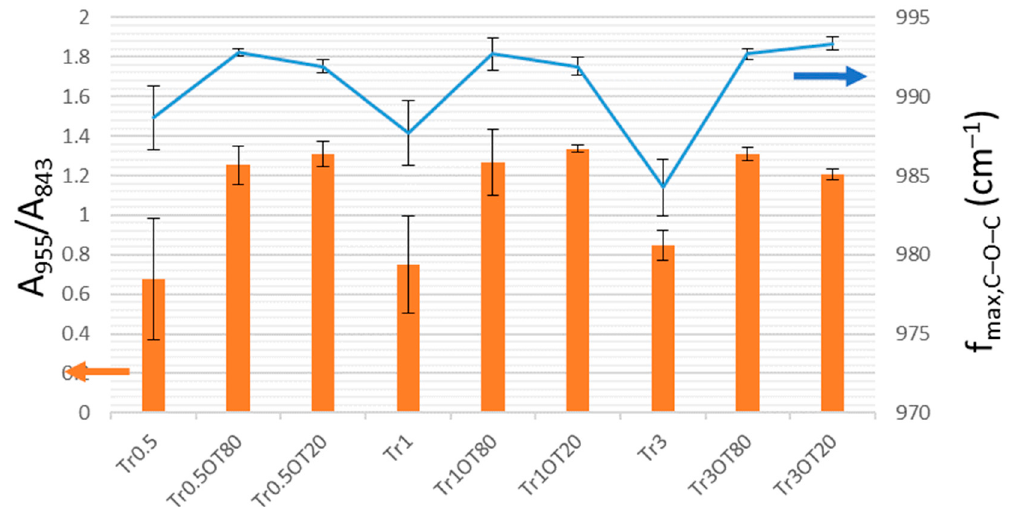
Figure 9. Quantitative crystallinity markers determined from ATR FTIR spectra of the trehalose-containing carrageenan films (0.5 g of carrageenan). A955/A843 represents absorbance ratio at 955 and 843 cm–1; fmax, C–O–C represents the frequency of the maxima for the glycosidic linkage stretching in